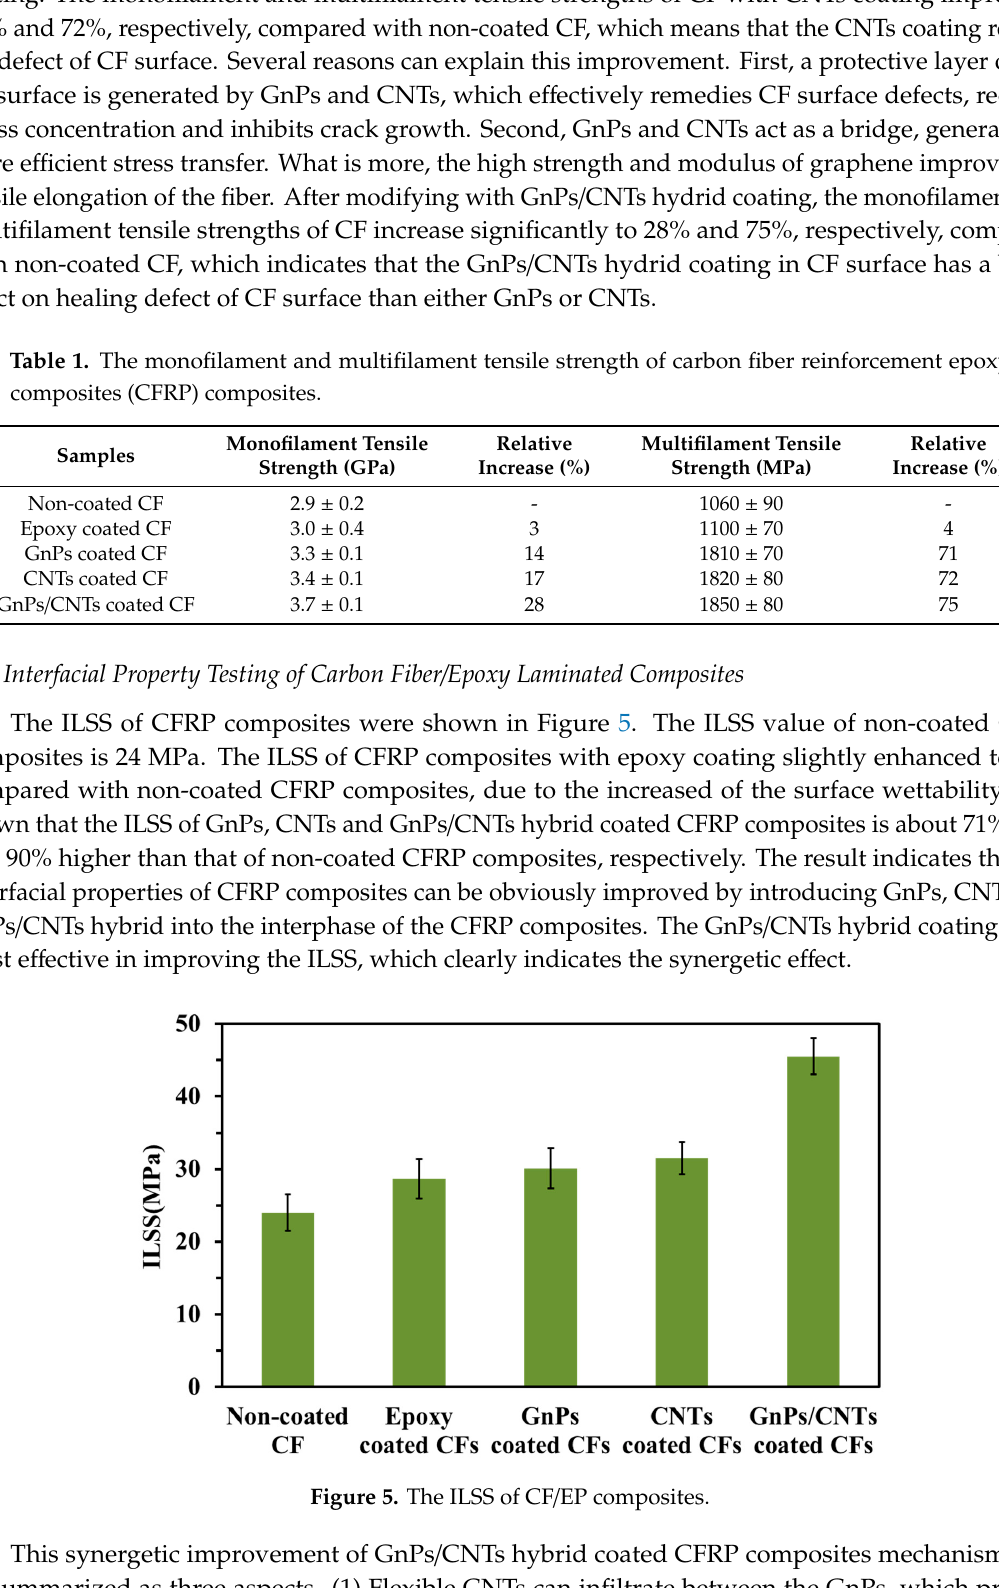
Figure 5. The ILSS of CF/EP composites.